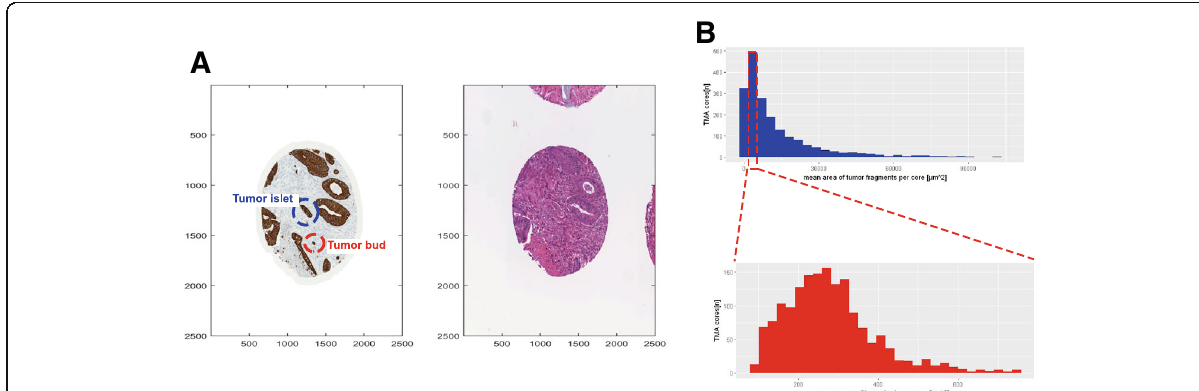
Fig. 2 Definition and detection of tumor buds. a Example single TMA core stained for pan-cytokeratin and hematoxylin and eosin (HE). The red circle highlights a tumor bud next to larger tumor island. The blue circle is a small tumor part, which we referred to as a “ tumor islet ” ; which is a small tumor aggregate but does not meet all criteria for a tumor bud. b Histogram of pan-cytokeratin positive tumor area per core (upper plot) and pan-cytokeratin tumor bud area per core (lower plot). One can see that the mean area of all tumor fragments (upper panel) shows a huge dispersion (x-axis 0 – 100,000), whereas the mean area of the tumor buds is less distributed (x-axis 0 –